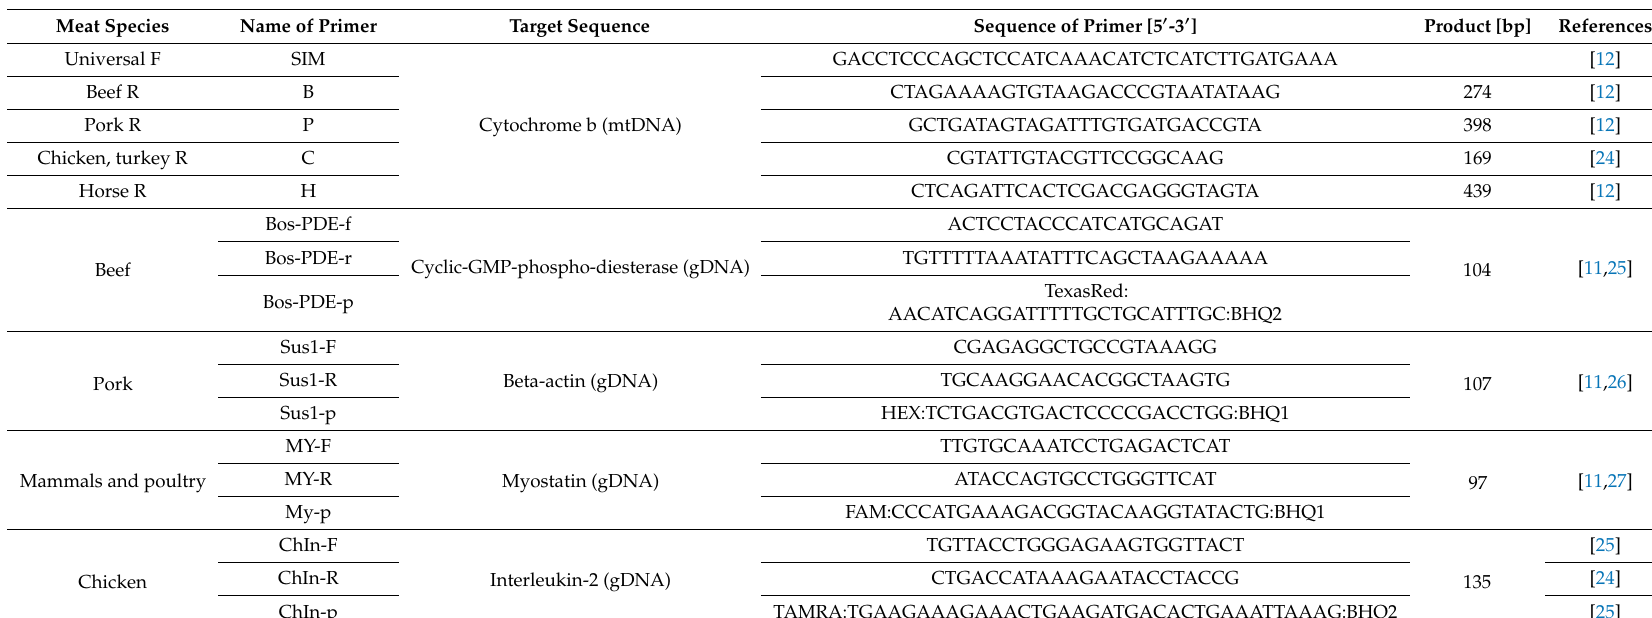
Table 2. Primers and probes used in this